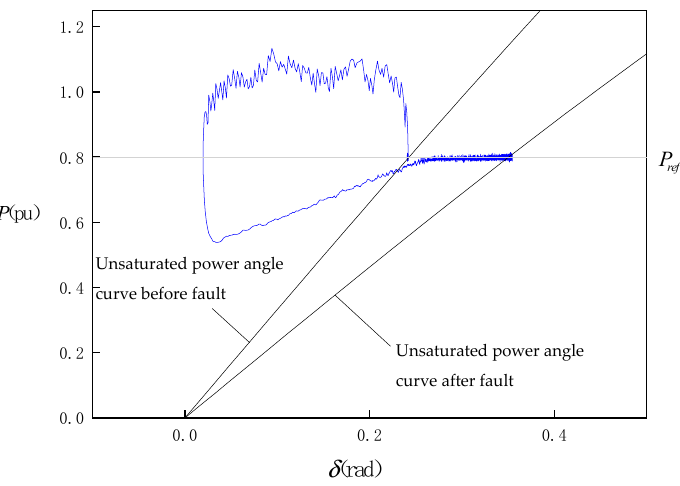
finally stabilizes at the intersection of the unsaturated power-angle curve and the given power value P ref .